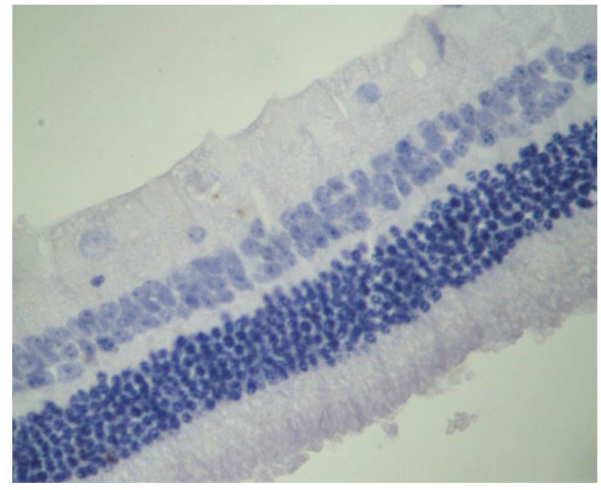
Figure 14. Group M. Negative ( − ) immunohistochemical staining. TNF-a. × 160.